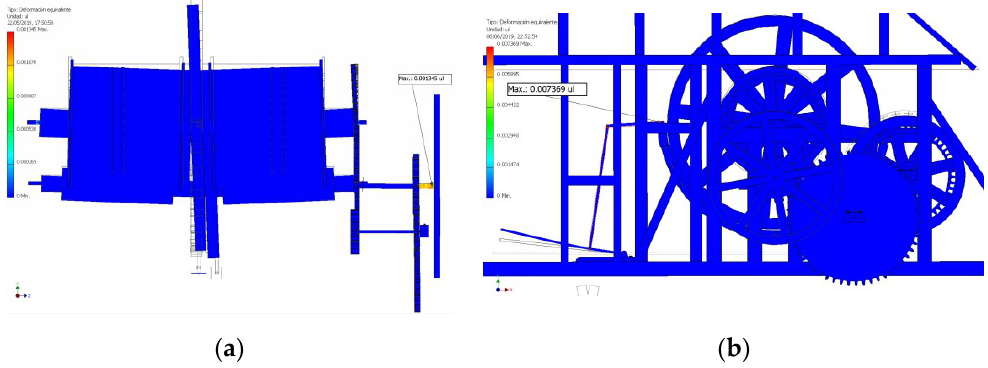
Figure 24. Location of the highest deformation: ( a ) blockage situation and ( b ) braking situation.